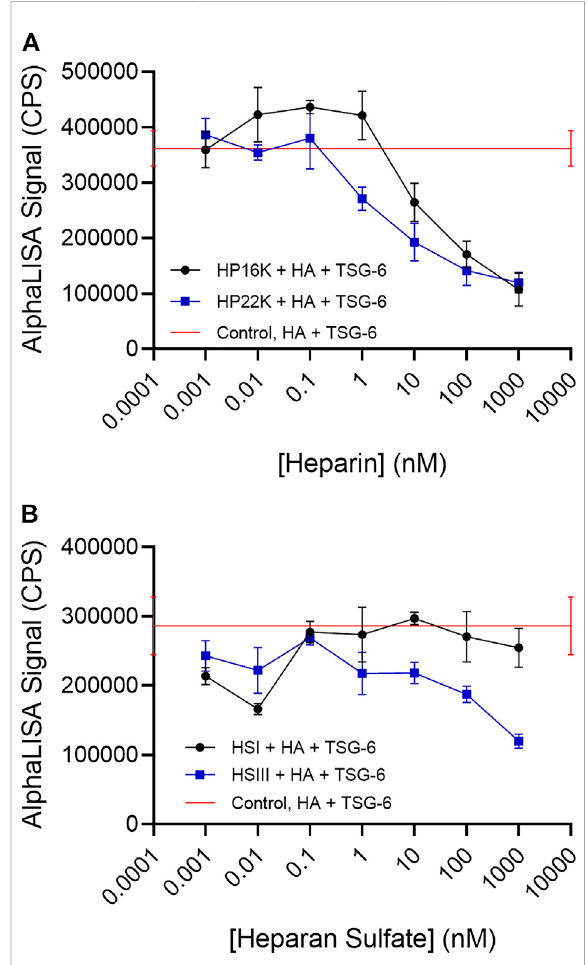
FIGURE 4 (A) Heparin and (B) Heparan sulfate can disrupt TSG-6- mediated HA crosslinking. Heparan sulfate with a low degree of sulfation (HS-I)is lesseffective than highly sulfated heparan sulfate (HS-III). In theAlphaLISA experiments,end-biotinylatedHA at 1 nM fi nalchainconcentrationwasincubatedtogetherwithTSG-6 protein at 150 nM fi nal concentration, and increasing concentrations of heparin (HP) or heparan sulfate (HS) in free solution, then mixedwith streptavidin-coated donor and acceptor beads for detection of HA crosslinking. The control solution contained bHA, TSG-6, and beads only ([HP] or [HS] = 0), and is shown as a line to better indicate the associated standard deviation. Signal was recorded as counts per second (CPS). Each experiment was repeated at least three independent times, and a representative experiment is shown. Each data point represents the mean ± standard deviation from quadruplicate